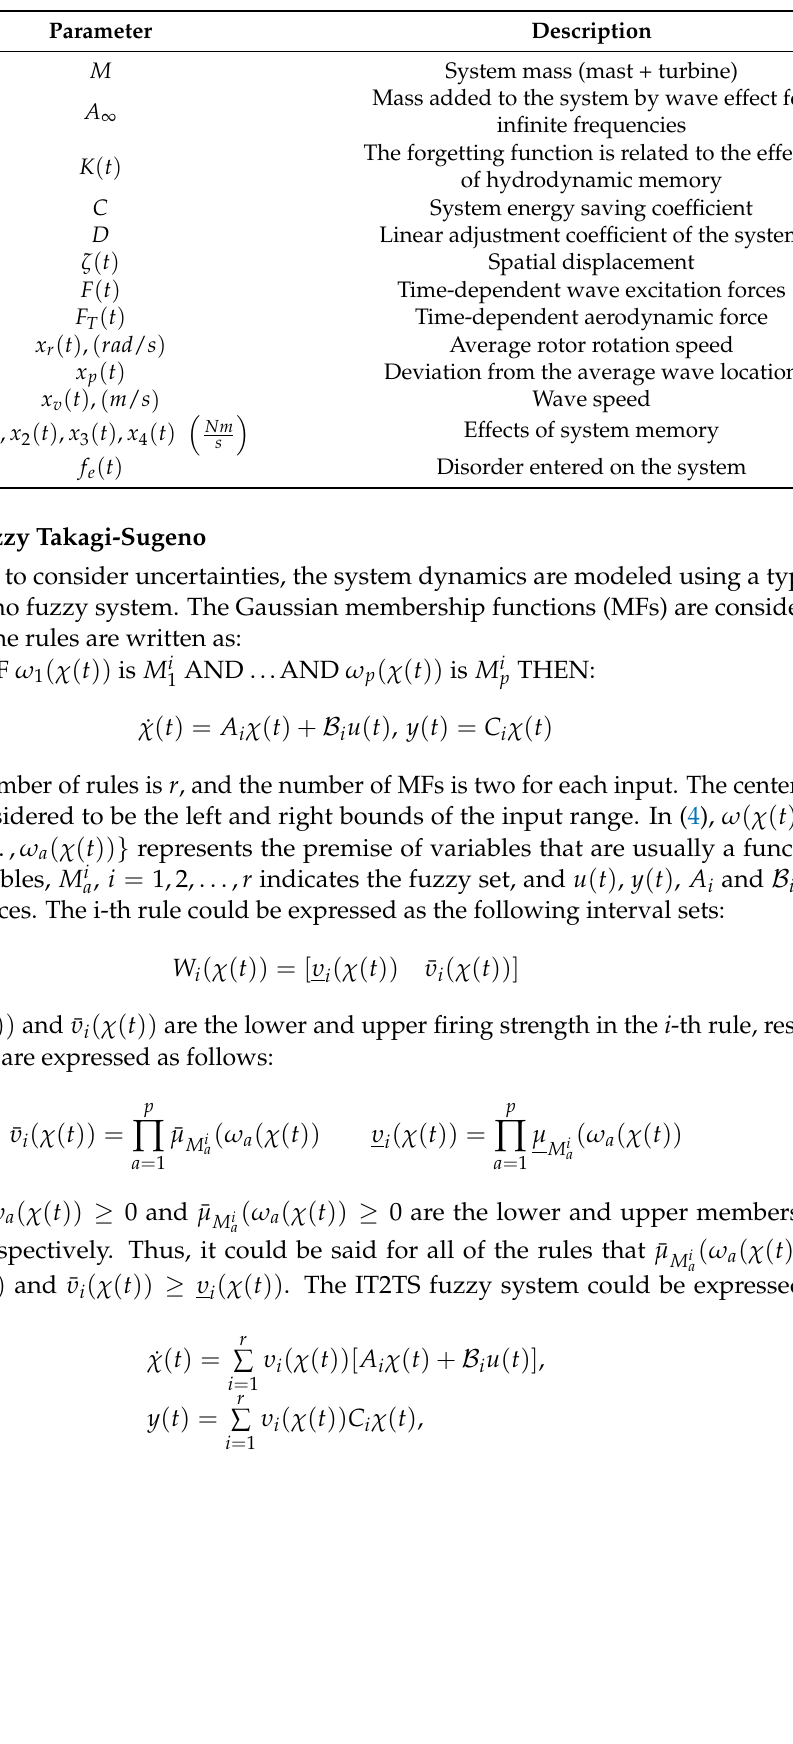
Table 1. Parameter